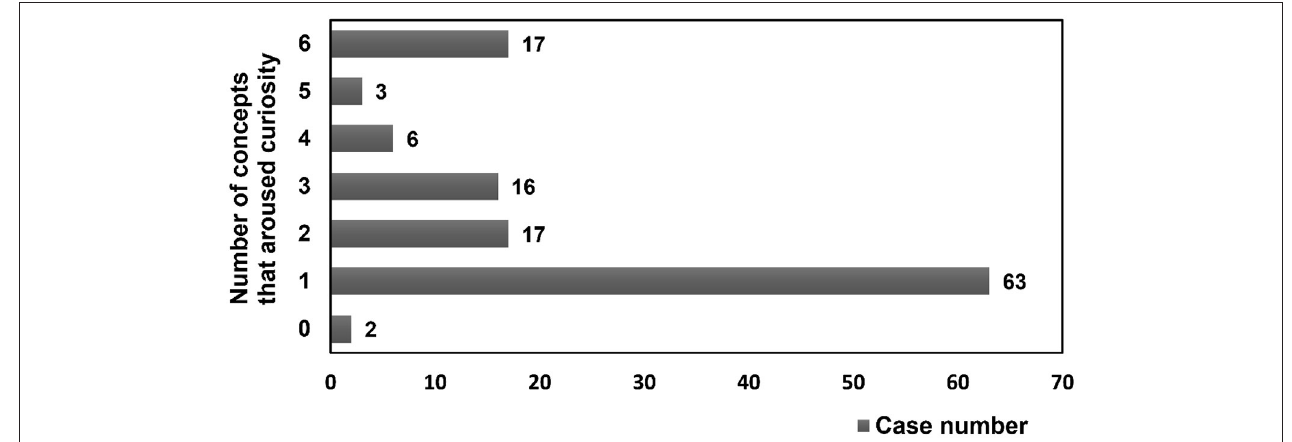
FIGURE 2 | Number of concepts that aroused curiosity in participants.